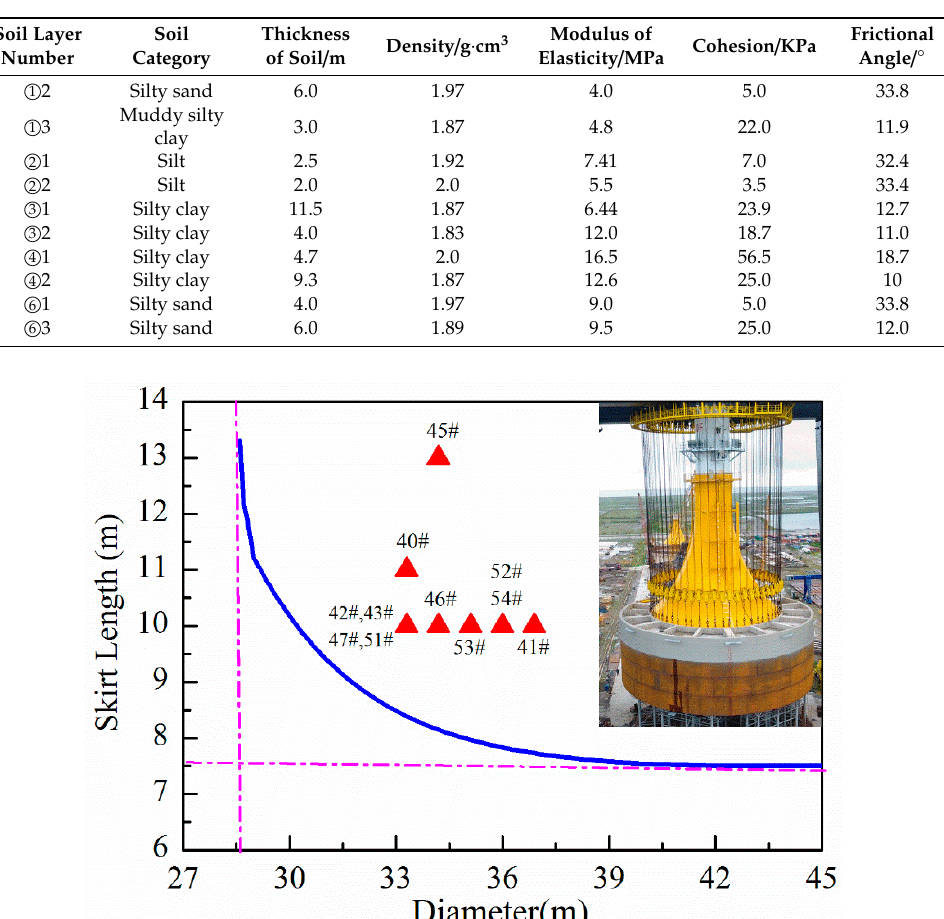
Figure 23. The dimensional safety threshold curve of WSBF.